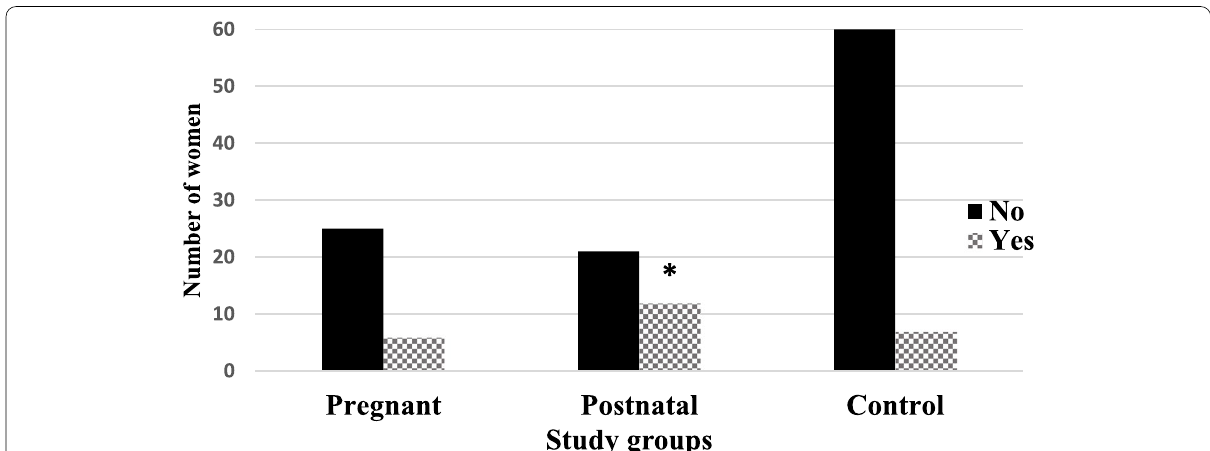
There was a statistically significant difference between groups regarding the distribution of insomnia. Demonstrates the distribution of subjective sleep quality in perinatal women versus the control group. Reported subjective sleep quality was significantly different between the two groups * P value was considered significant at < 0.0